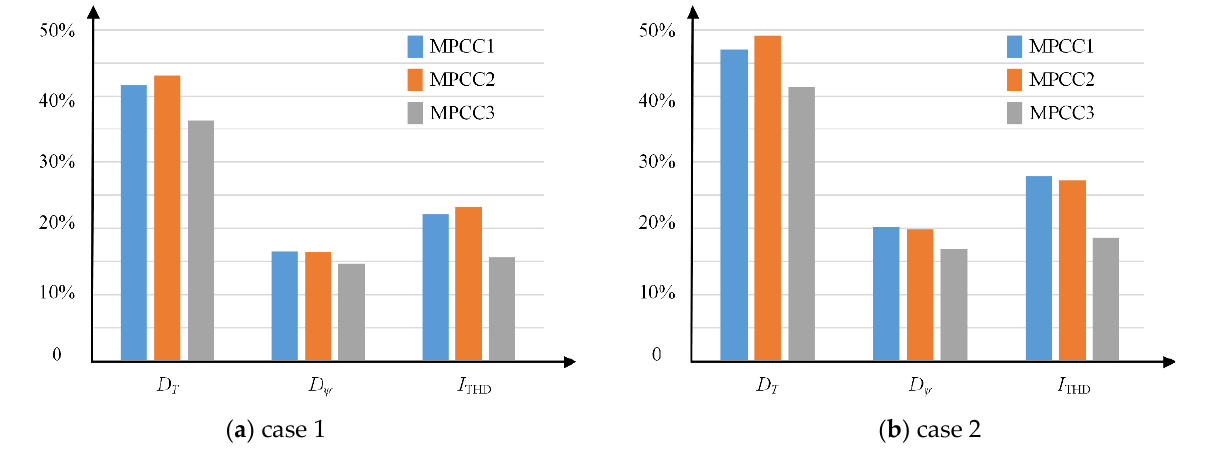
( c ) MPCC3 Figure 10. Experimental results of MPCC1, MPCC2 and MPCC3 (case 2). The total harmonic distortion of the output current I THD is used as the current perfor-